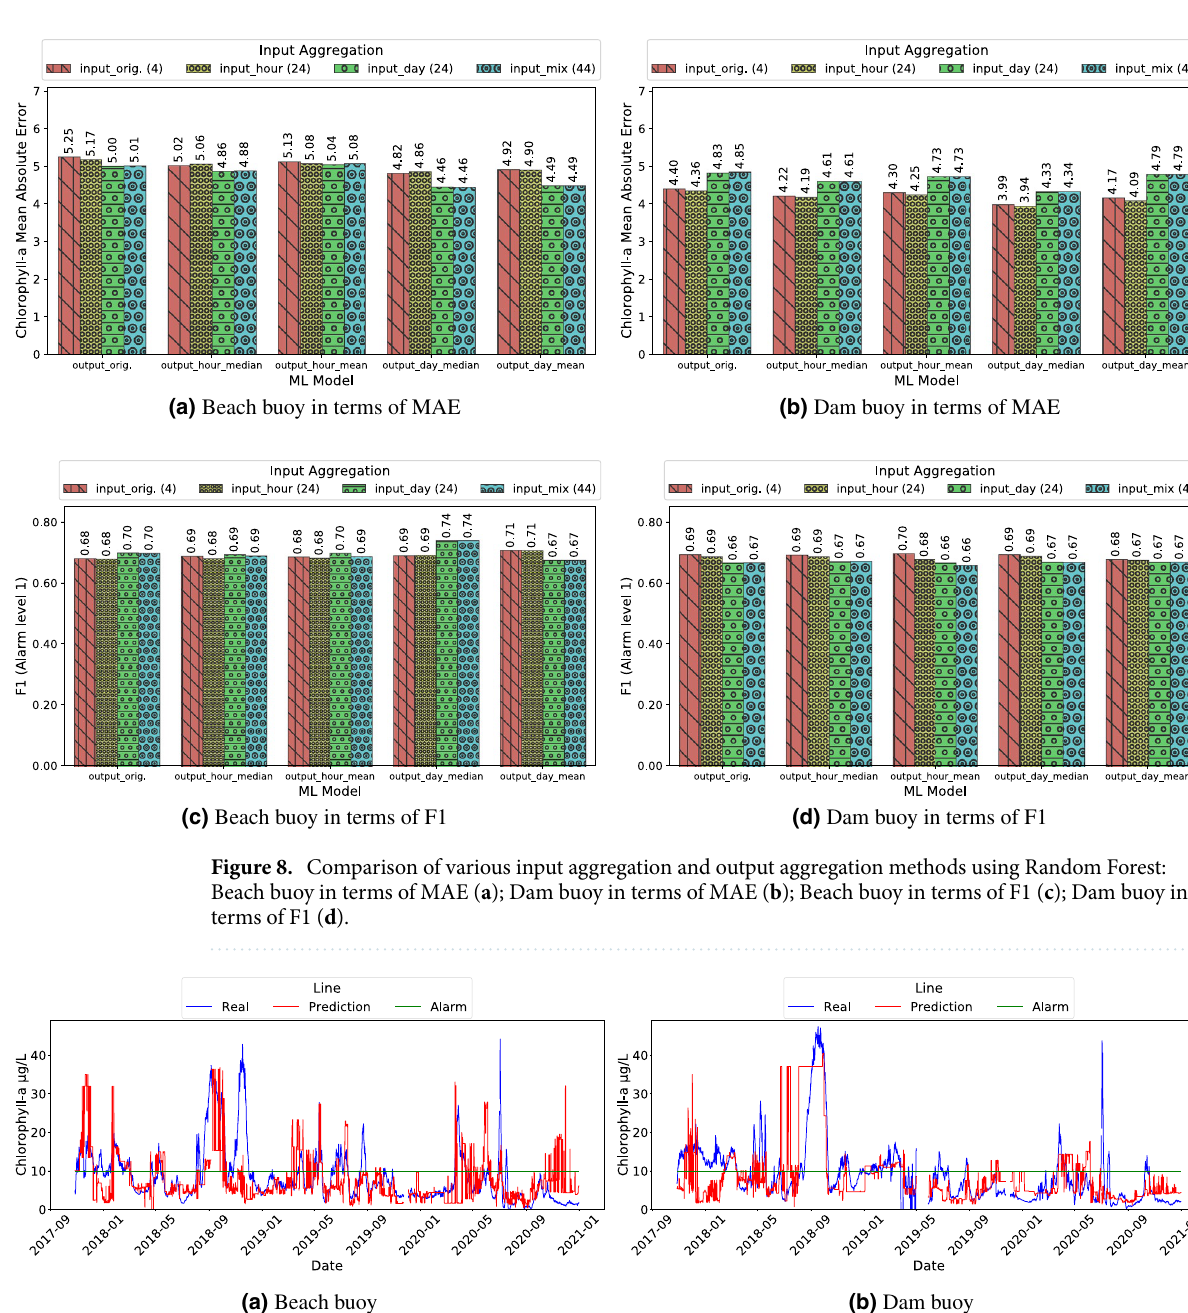
Figure 9. Line plots of Chl- a and RF predictions (time is shown in x-axis and the Chl- a value in y-axis) using the median of Chl- a over a day as the output variable (output_day_median) and aggregating all inputs over